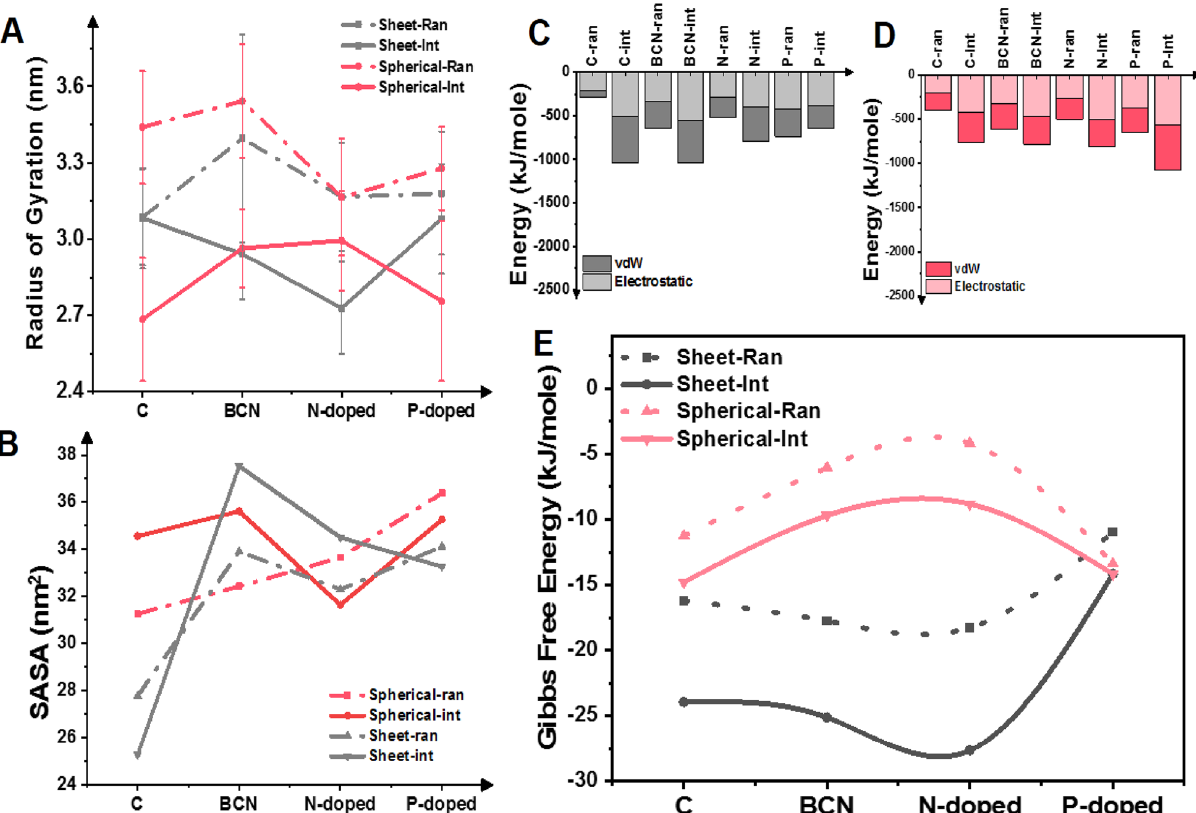
Figure 2. Initial analysis of PNPs in the presence of carbon-based nano-objects. (A) Results of mean Rg calculated in each simulation show that the presence of nano-objects in the interface method gives rise to smaller NPs in comparison with their peers in the random style. ( B) The solvent available surface area of the assemblies formed in the presence of nanocarbon. ( C,D) Interaction energies of polymeric strands within the micelles are plotted for nano-sheets and spherical fullerene-based materials, respectively. As is shown, the vdW interaction is the dominant interaction in the assembly process. ( E) Gibbs free energy as the absolute stability criteria have been calculated for samples. In agreement with Rg results, NPs that are assembled in the interface of ACN and water are more stable and have lower energy levels. Moreover, NPs produced in the presence of graphene and its dopants are more stable than NPs assembled in the presence of fullerene and its